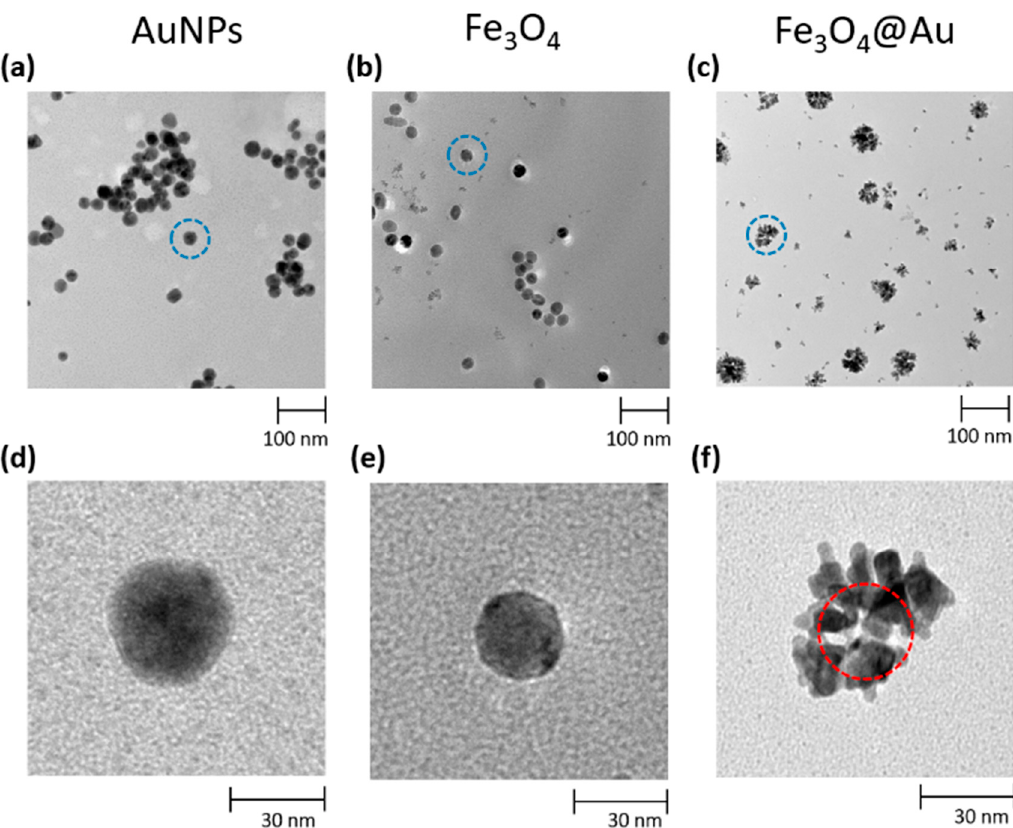
Figure 1. TEM micrographs of ( a ) AuNPs, ( b ) Fe 3 O 4 NPs and ( c ) Fe 3 O 4 @Au core-shell NPs (gold nanoflower grown on a magnetic core). In the lower part of the figure the circled portions in panels ( a , b , c ) are respectively reported in detail in panels ( d , e , f ). In panel ( f ) the magnetic core is highlighted with a red circle.